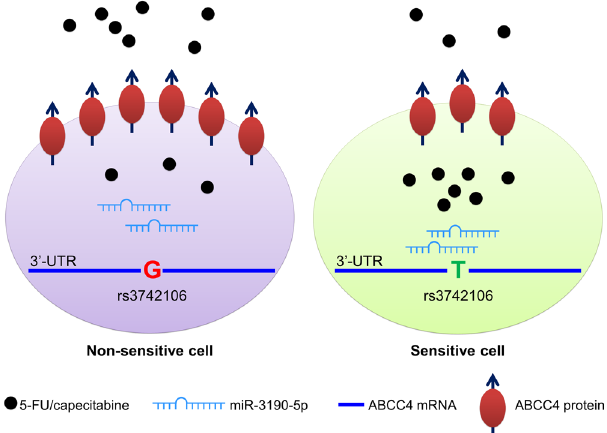
Figure 2. The molecular mechanism of individual response to chemotherapy. Rs3742106 G-allelic ABCC4 disrupts the binding of miR-3190-5p and results in over-expression of ABCC4 and consequent low intracellular concentration of drug, as well as resistance to chemotherapy. On the contrary, the T-allelic ABCC4 generates a binding-site for miR-3190-5p and leads to attenuated expression of ABCC4 protein, elevated intracellular concentration of 5-FU, and increased sensitivity of cells to the